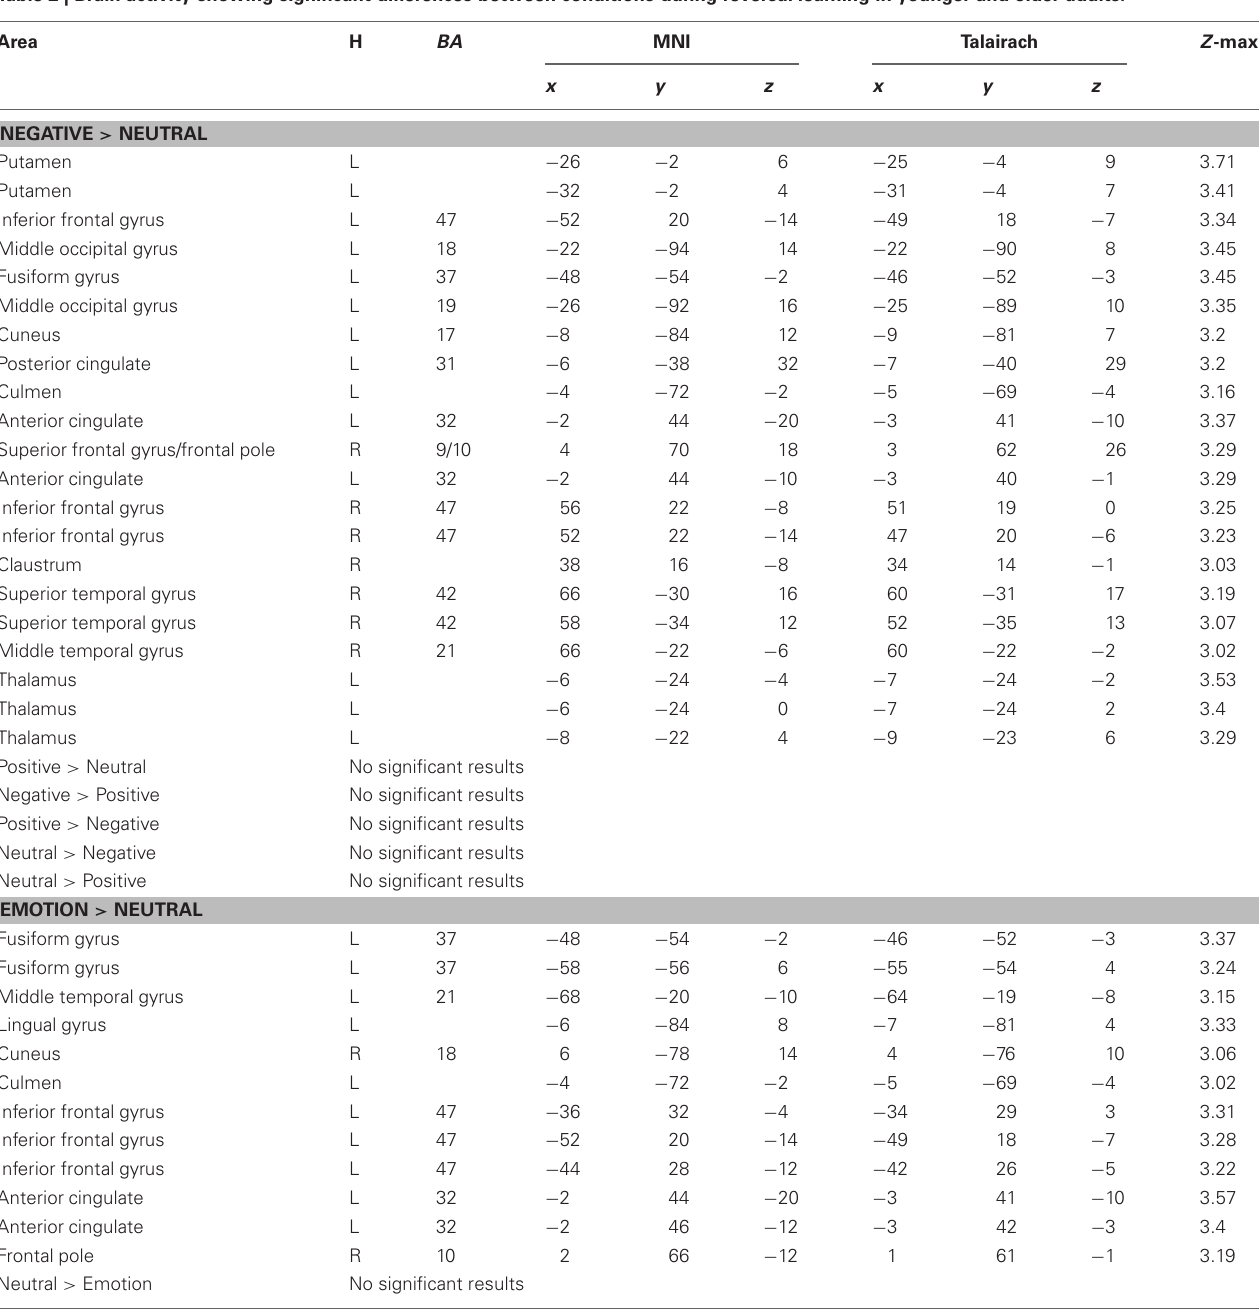
Table 2 | Brain activity showing significant differences between conditions during reversal learning in younger and older adults.